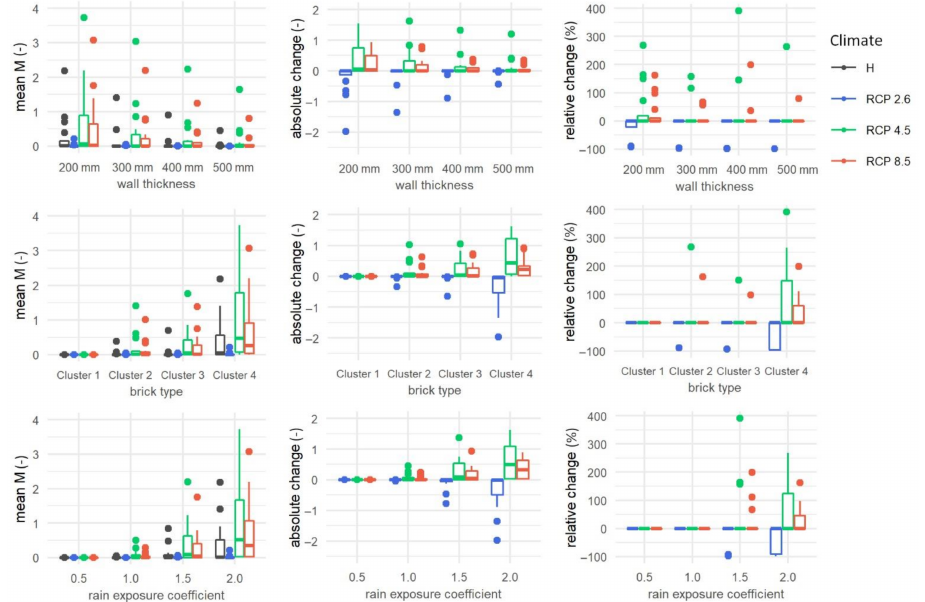
Figure 6. Mean value and mean absolute change in M for the SW orientation per parameter variation: wall thickness, brick type, insulation thickness and rain exposure coefficient.